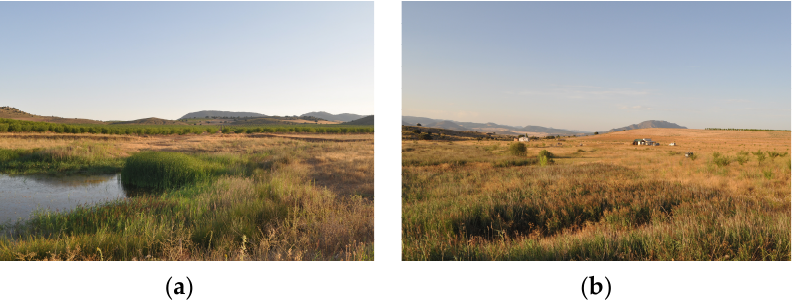
Figure 3. ( a ) Riparian zone and ( b ) forest garden, ERC Camp Altiplano—author’s photo 07/2022